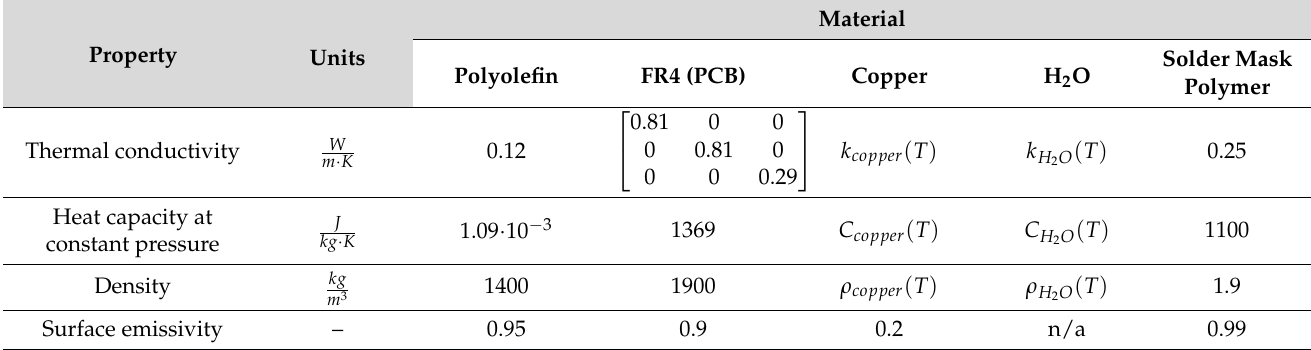
Table 1. Thermophysical properties of the materials (see Figure 2). Not applicable material properties, such as the emissivity of water which is enclosed within the geometry, are marked as n/a. FR4 thermal conductivity is given in the form of a matrix because its value changes depending on the direction of the heat transfer. The values of thermal conductivity, heat capacity at constant pressure, and density of copper and water depend on the temperature and are taken from the library of the computing